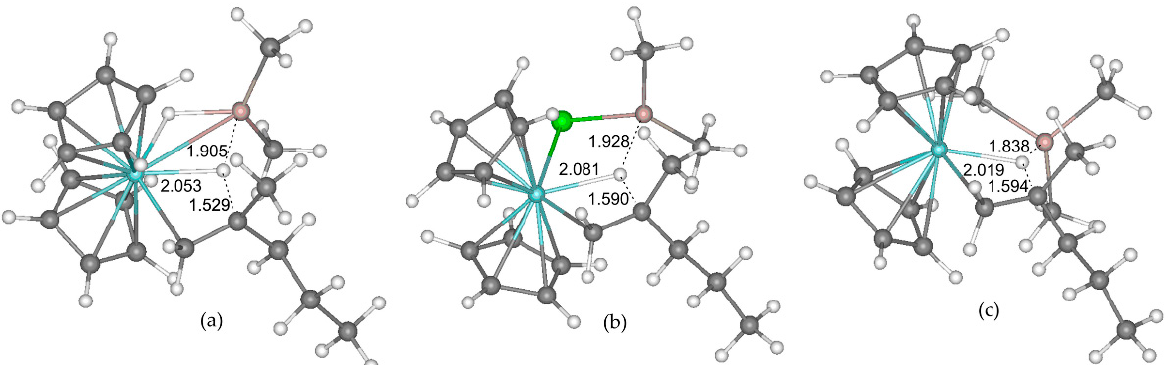
Figure 19. Calculated geometries of the transition states of β -hydride elimination in Cp 2 Zr( μ -X)(CH 2 CHMePr)AlMe 2 model complexes. ( a ) X = H; ( b ) X = Cl; ( c ) X = Me. The distances Zr–H, Al–H and β C–H are specified (Å). Reprinted with permission from [41]. Copyright (2019) MDPI.